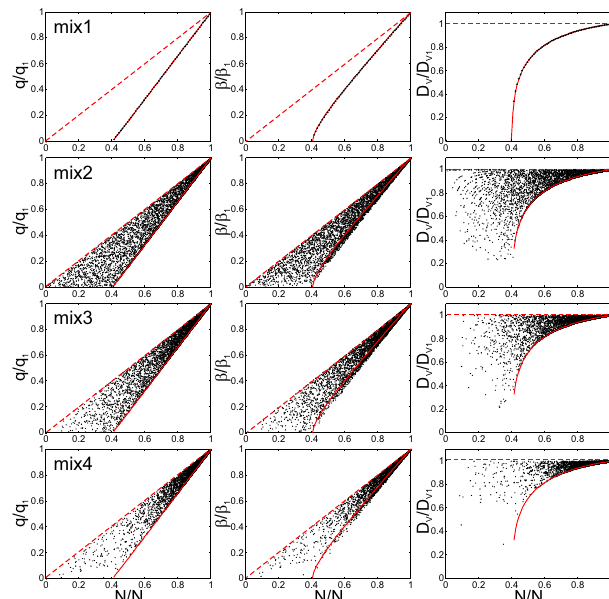
Figure 9. Simulation of stochastic mixing corresponding to stages 1–4 as indicated in Fig. 8. Solid red lines indicate the normalized dependences q , β , D v vs. N for the primary stage of homoge- neous mixing. Dashed red lines indicate the same dependences for inhomogeneous mixing. The initial conditions used for the simu- lations were the following: H = 1000m, T 1 = T 2 = 0 ◦ C; RH 2 = 0 . 5; D 1 = 10µm, N 1 = 500cm − 3 .